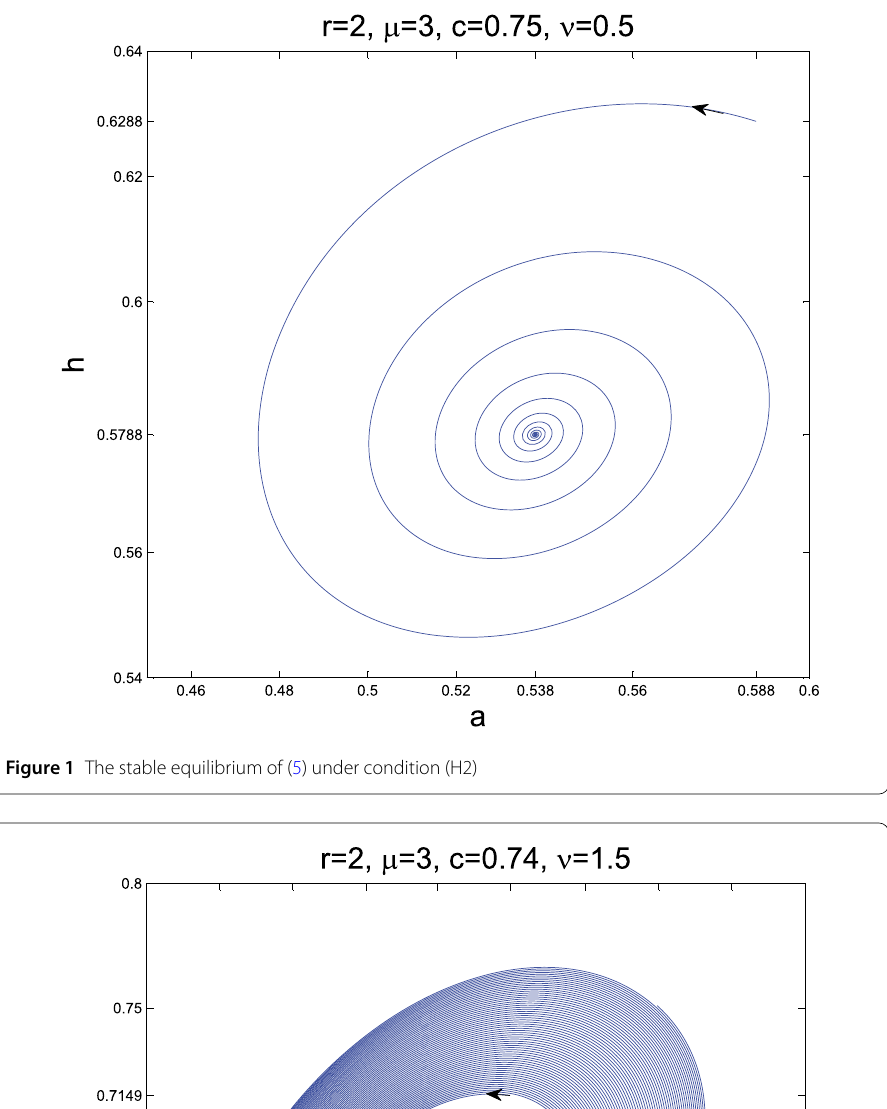
Figure 1 The stable equilibrium of (5) under condition (H2)